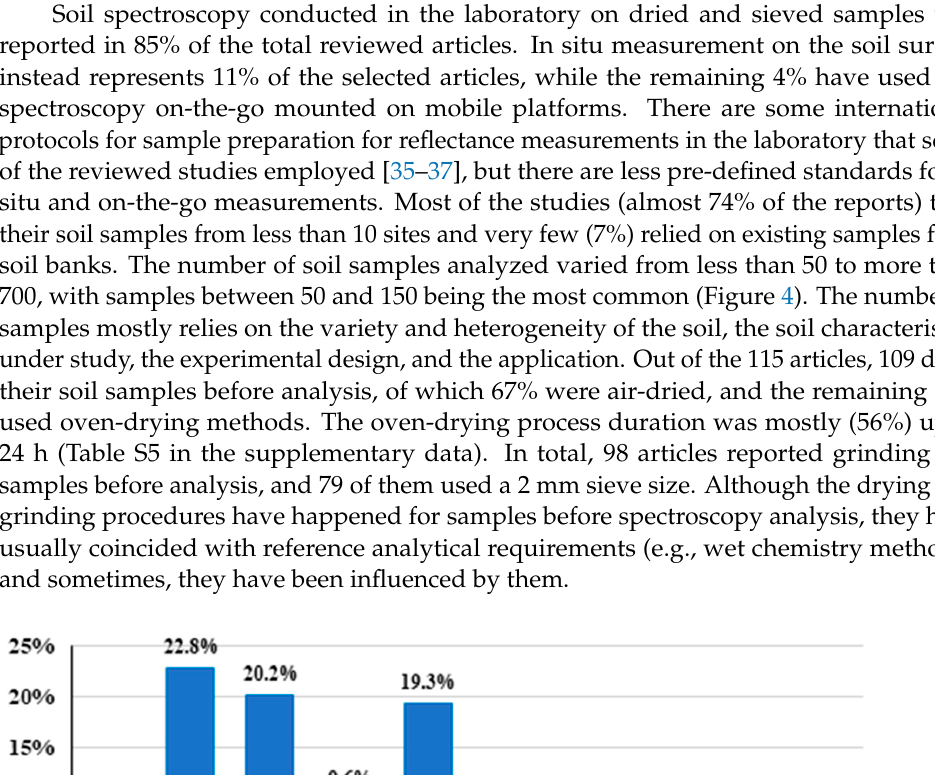
Figure 4. Number of soil samples used in the reviewed articles .